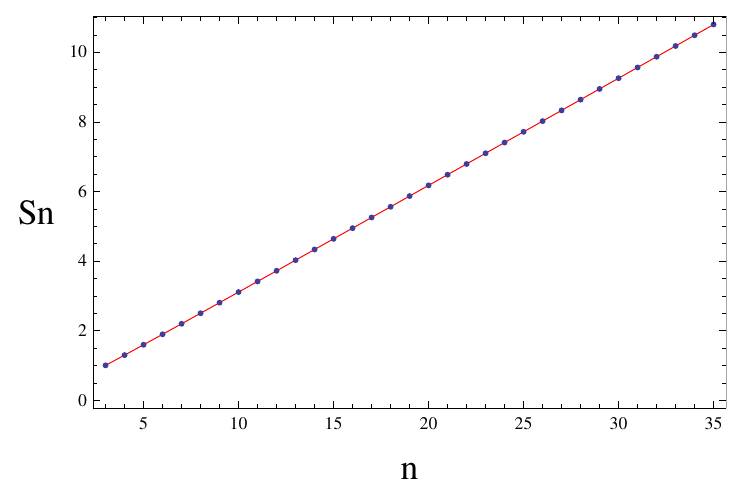
Figure 5 . The entanglement entropy of gauge (cid:12)elds with algebra A .